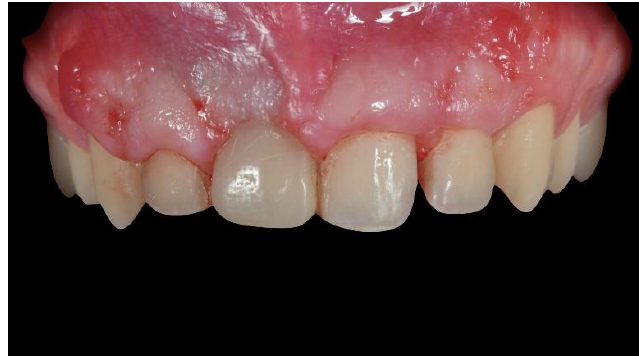
Figure 6. Intraoral view 3 weeks after surgery and sutural removal. Materials 2020 , 13 , x FOR PEER REVIEW